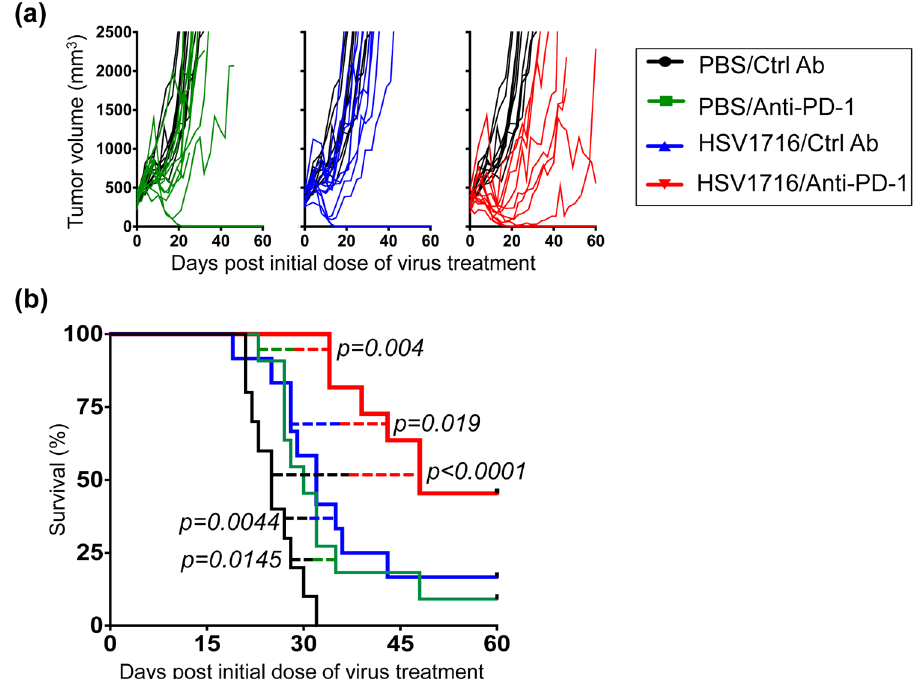
Figure 2. Combination of HSV1716 with anti-PD-1 antibody significantly prolongs survival with several complete responses in the more immunogenic female M3-9-M tumor model. Female C57BL/6 mice were implanted with 5 × 10 6 M3-9-M cells subcutaneously and treated with three intratumoral injections of 10 8 pfu HSV1716 followed by intraperitoneal injections of anti-PD-1 antibody as described in Fig. 1a. ( a ) Individual tumor volumes of mice treated with anti-PD-1 (green lines; n = 11), HSV1716 (blue lines; n = 12) and combined therapy (red lines; n = 11) plotted against tumor volumes recorded for control mice (black lines; n = 10). ( b ) Kaplan-Meier survival curves for each treatment group demonstrate the improved efficacy of combining PD-1 blockade with HSV1716 virotherapy in the more immunogenic female M3-9-M model. Mice deemed cured were subsequently re-challenged with M3-9-M injection on their contralateral flank and found to be resistant to new tumor growth (see Fig. S2). Survival data were evaluated for statistical significance with Log-rank Mantel- Cox